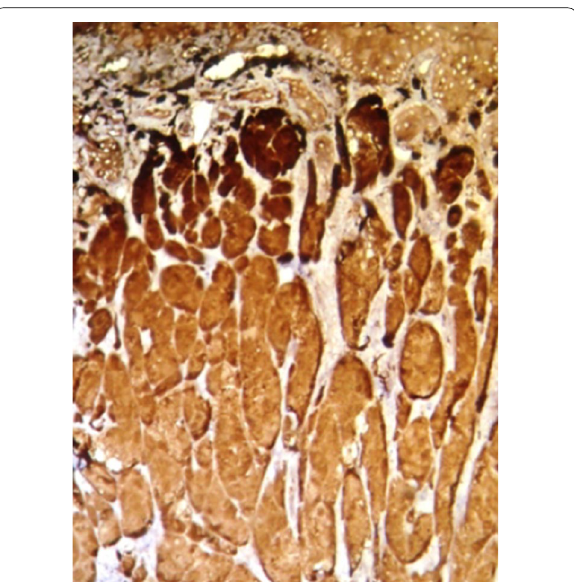
Fig. 3 The positive immunohistochemical study for the S-100 protein